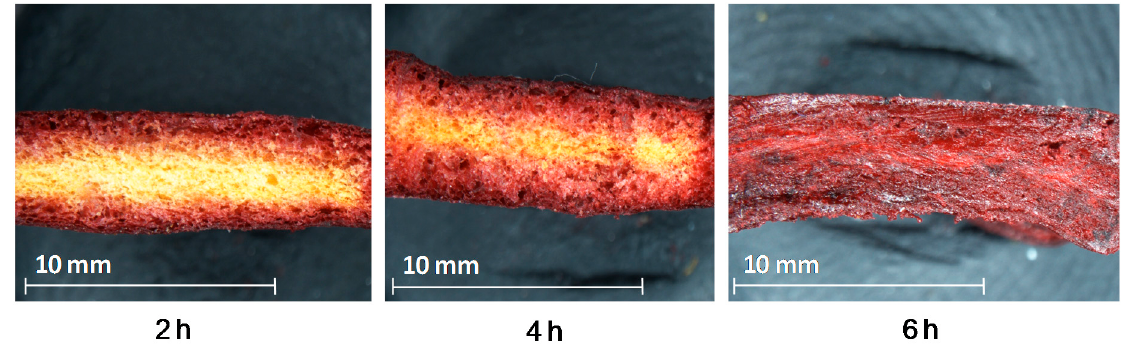
Figure 7. Cross-section of pumpkin slices pre-treated in concentrated chokeberry juice for 2, 4 and 6 h.